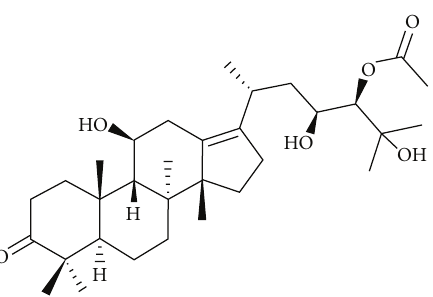
Figure 1: Molecular structure of alisol A